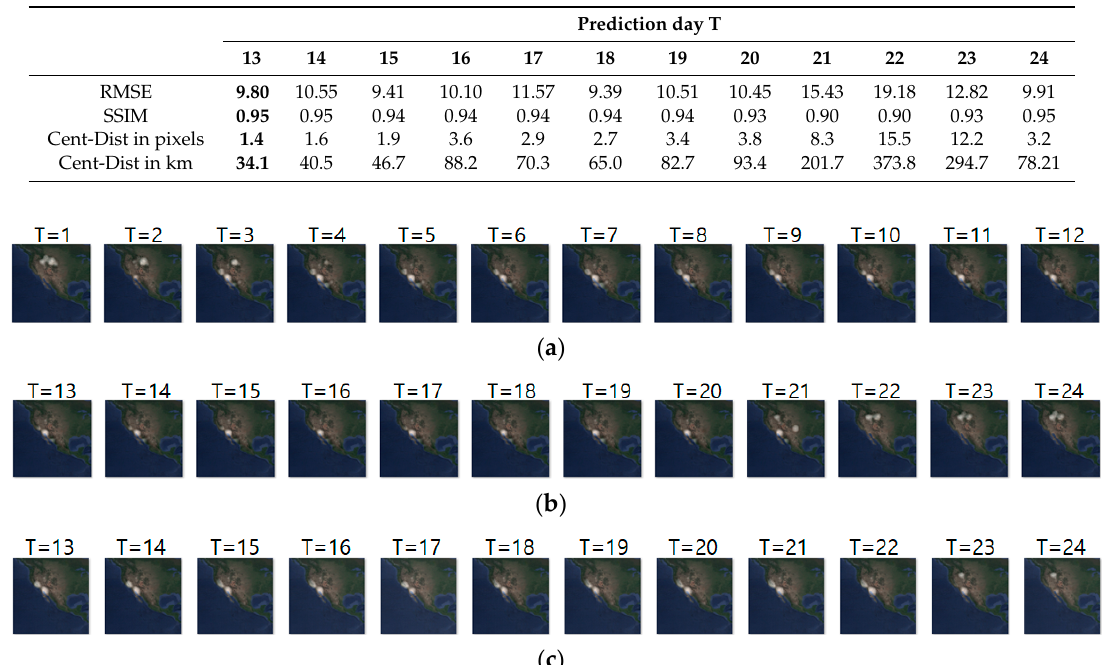
Table 16. Daily comparison of RMSE, SSIM, and centroid distance of case 10.